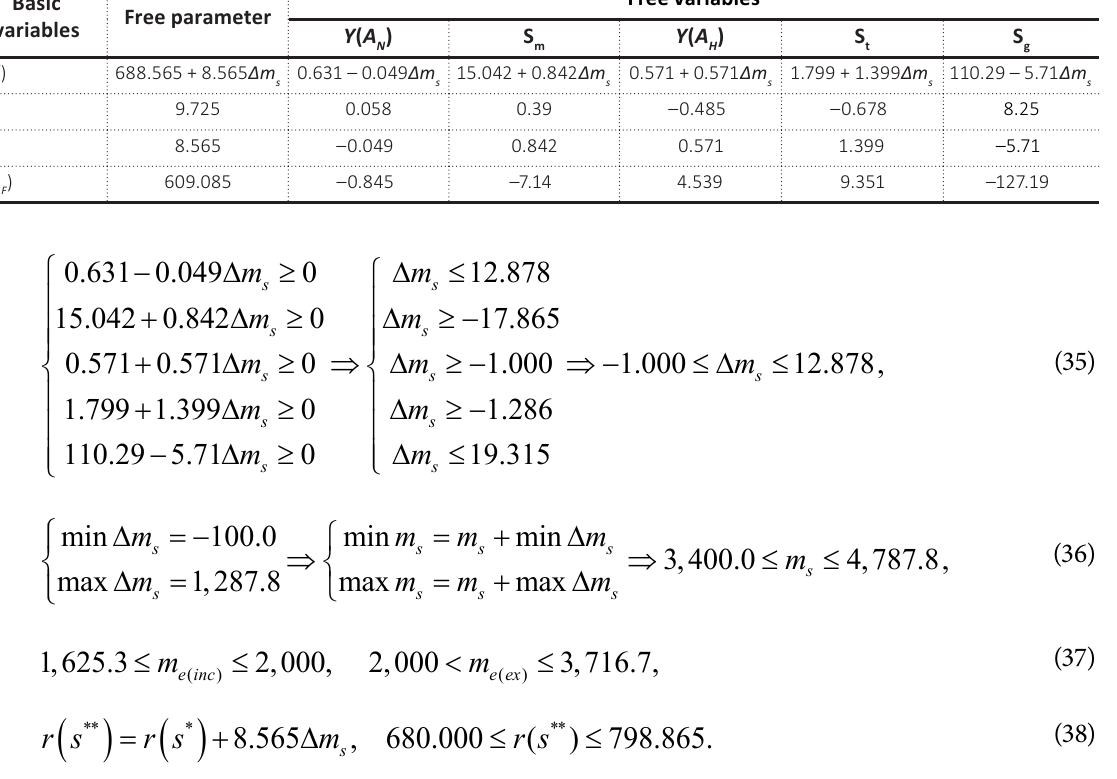
Table A7. Changes in restrictions on natural assets of green tourism destinations in the final iteration of